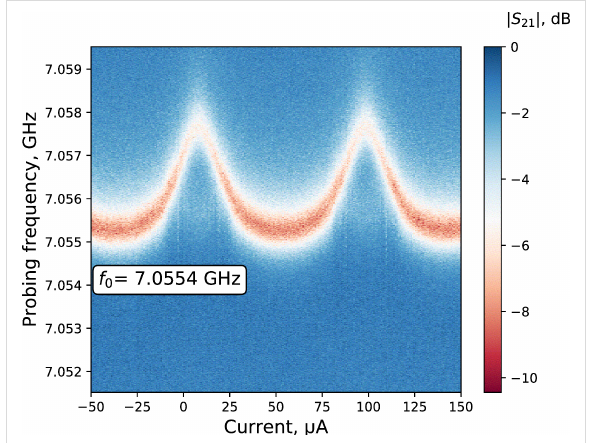
Figure 6: The qubit “sweet spot”. The transmission (color intensity graph with the blue color corresponding to the maximum and the red color corresponding to the minimum) at the resonator resonance fre- quency depending on the external flux bias for the frequency range from 7.0515 to 7.0595 GHz (vertical axis) and a constant probing power of − 120 dBm.